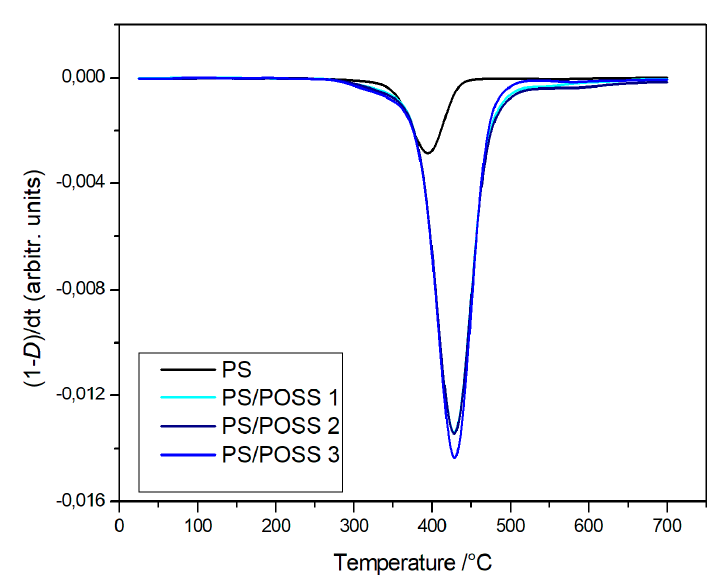
Polymers 2019 , x , x FOR PEER REVIEW 10 of 13 Figure 10. Differential thermogravimetric curves, in an inert atmosphere, for PS and samples 1 , 2 and 3 .